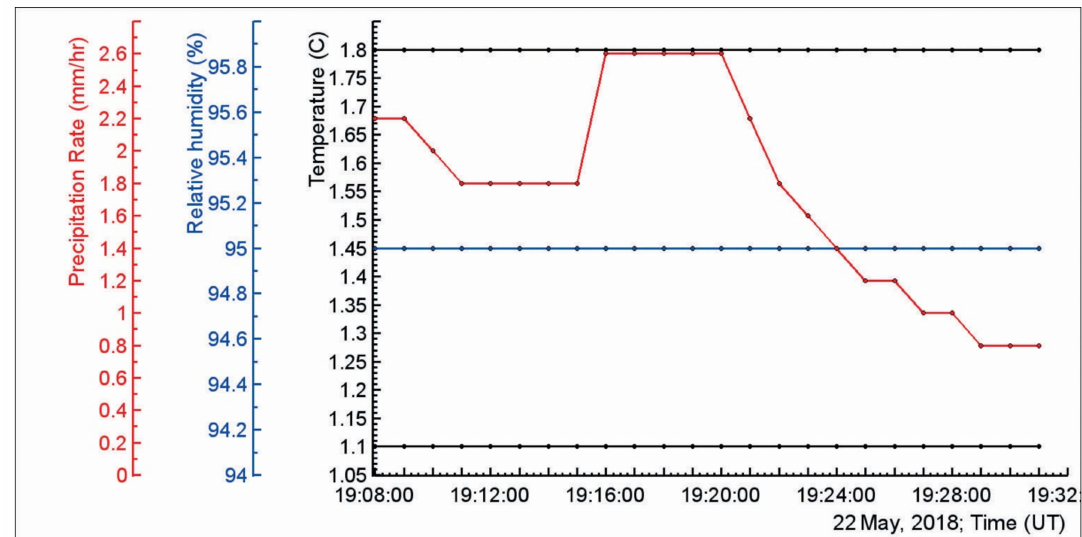
Figure 5. 1 min time series of outside temperature and dew point (black lines in the top and bottom); relative humidity (blue line in the middle); and rainfall (red line).